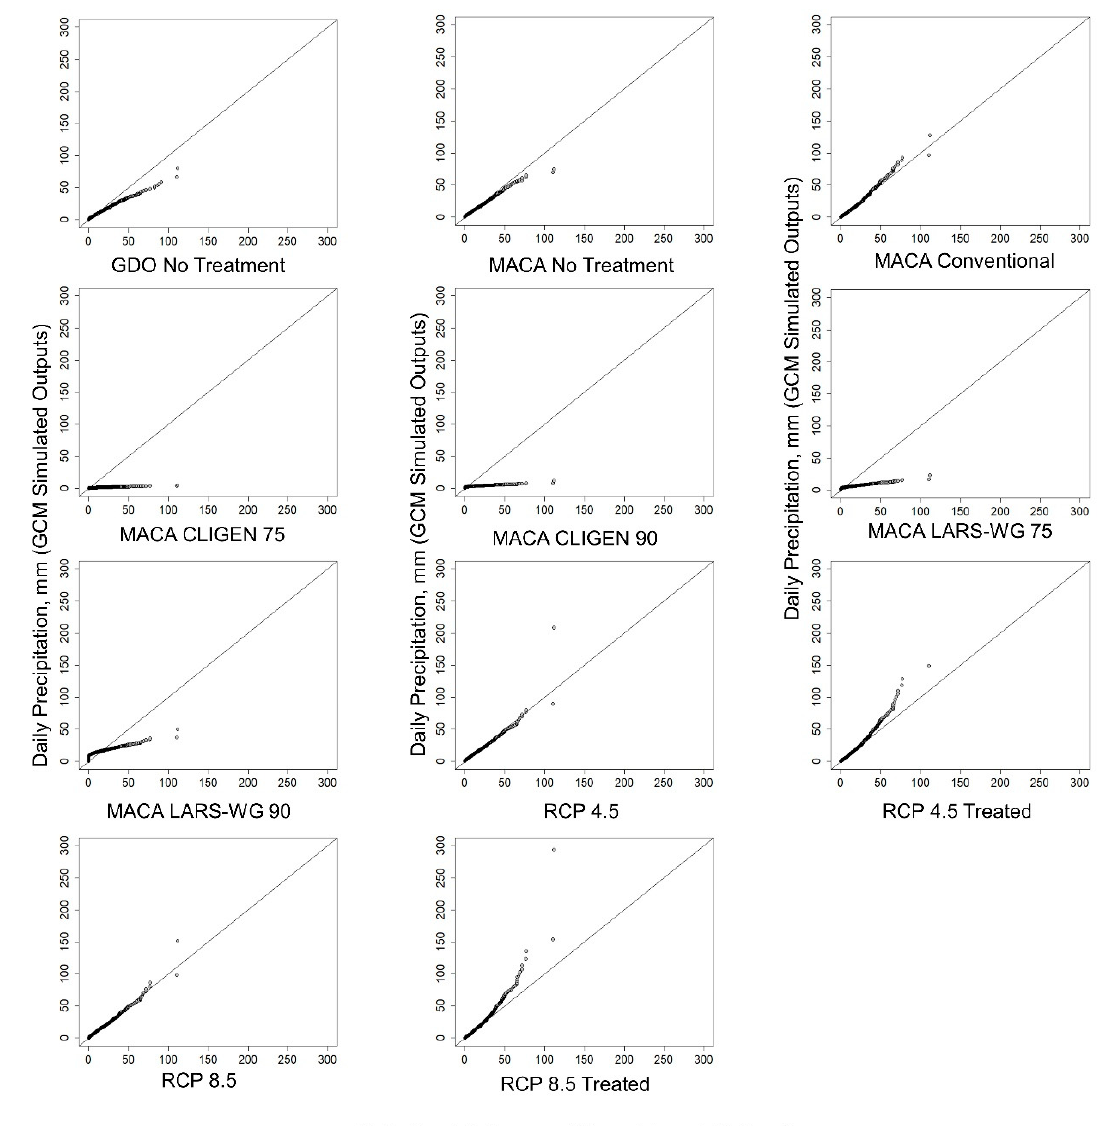
Figure 6. Q-Q plots to evaluate the performance of different bias correction methods for the period between 1966 and 2005 to reduce the bias in simulating values for daily precipitation, mm and present future climate scenarios (2006–2099) for Fort Wayne, IN.